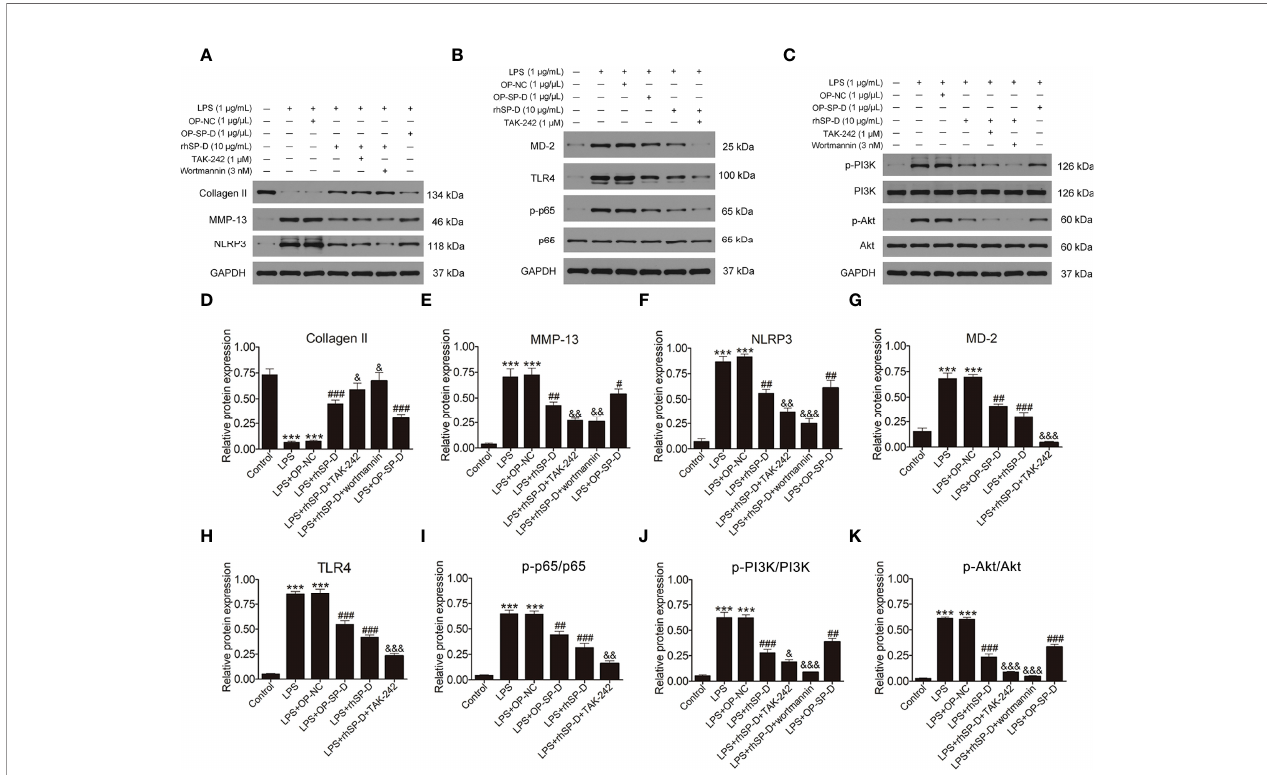
FIGURE 9 | Effects of SP-D on in fl ammation and ECM by suppressing TLR4-mediated PI3k/Akt and NF- k B signalings in chondrocytes. (A – C) The protein expression of Collagen II, MMP-13, NLRP3, p-PI3K, PI3K, p-Akt, Akt, MD-2, TLR4, p-p65, and p65 were assessed via western blotting with GAPDH as a loading control. (D – K) The ratios of Collagen II, MMP-13, NLRP3, MD-2, and TLR4 to GAPDH, and p-PI3K/PI3K, p-Akt/Akt, p-p65/p65 were analyzed. Data were expressed as mean ± SEM (n = 3). ***P < 0.001 vs. the control group; ## P < 0.01 and ### P < 0.001 vs. the LPS group; & P < 0.05, && P < 0.01 and &&& P < 0.001 vs. the LPS + rhSP-D group. OP-SP-D, SP-D overexpressing plasmid; OP-NC, Negative control